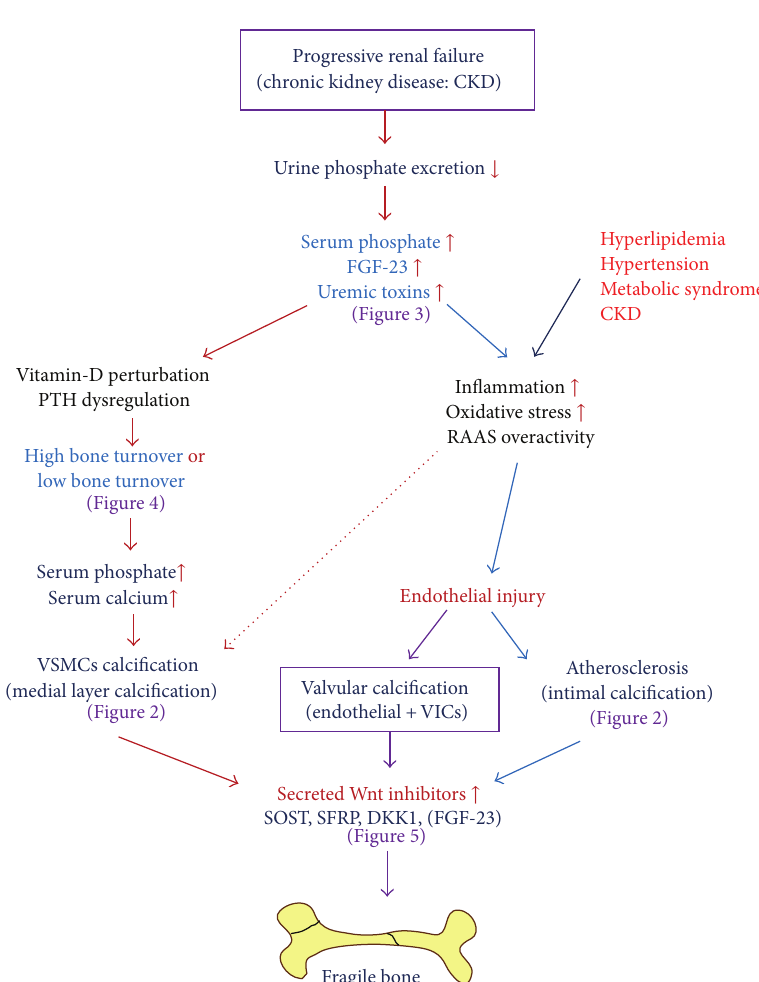
Figure 1: Scheme for possible mechanisms of vascular calcification in CKD. Vascular calcification is a prominent feature of arterial disease in CKD and may have an impact on cardiovascular mortality through modulating both arteriosclerosis (arterial stiffening) and atherosclerosis. In CKD, abnormal mineral metabolism, predominantly hyperphosphatemia and hypercalcemia, facilitates the progression of the active process of osteogenesis in vascular smooth muscle cells (VSMCs) resulting in arteriosclerosis calcification. However, the disruption of endothelial-derived relaxing factors may signal an early stage in atherosclerosis. Hyperlipidemia, hypertension, metabolic syndrome, and CKD are the major causes of endothelial injury, partly through increase of inflammation or oxidative stress. Major cell players are endothelial cells (or valve interstitial cells; VICs), leukocytes, and intimal smooth muscle cells (SMC). Focal calcification within atherosclerotic plaques is due to both active (osteogenic) and passive (cellular necrosis) processes. The phenotypic osteocyte in calcified vessels/valves may secrete Wnt inhibitors, which may fight back inhibition of bone